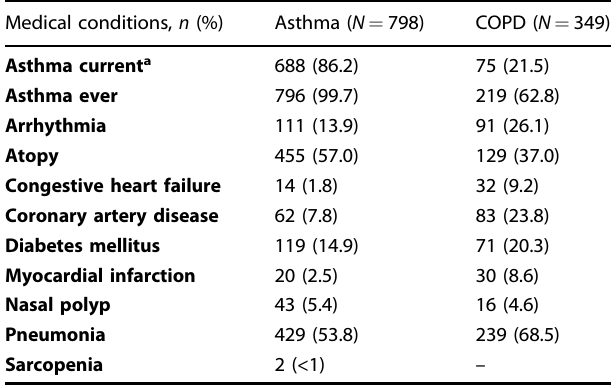
Table 6. Select medical conditions ever recorded in Ext-SLS primary care EHR data up to and including the date of Ext-SLS consent.